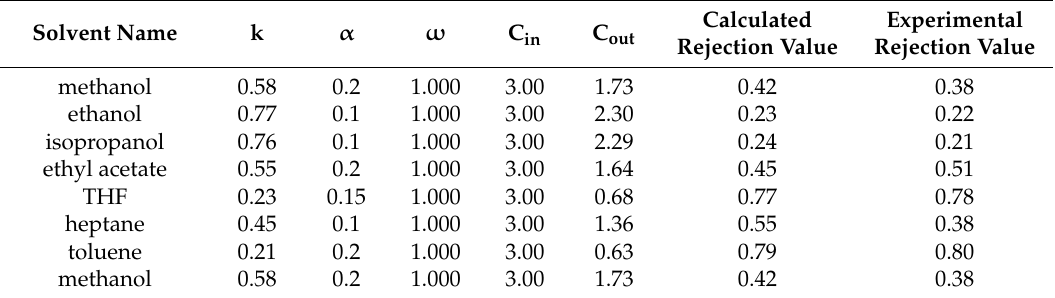
Table 6. Evaluating the proposed model by solvent flux and solute rejection value through the ceramic membrane reported by [44]. The pore size diameter is 0.9. Tridodecylamine: van der Waals diameter was 1.08